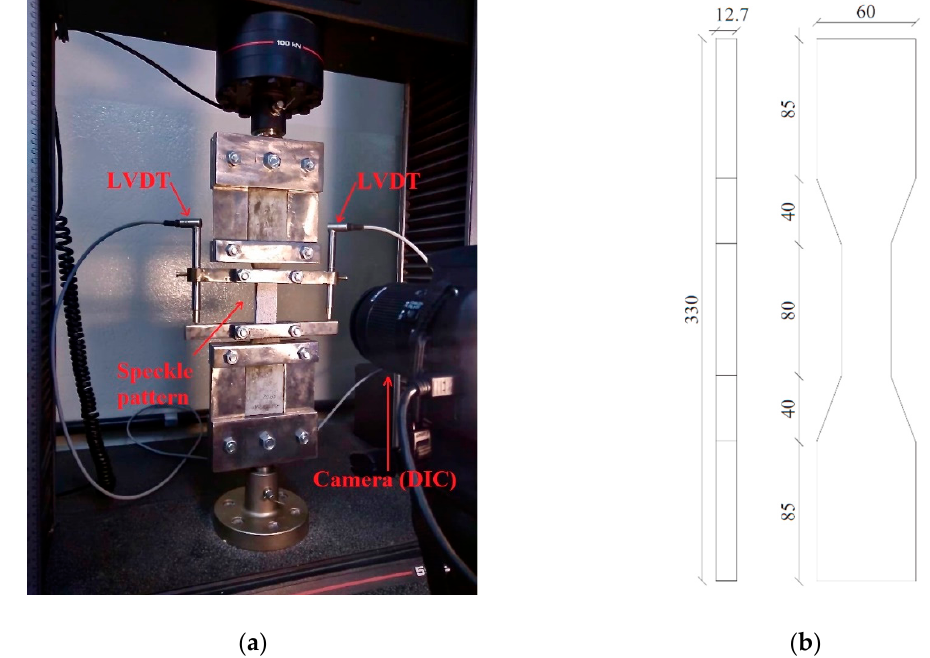
Figure 4. The direct uniaxial tensile test: ( a ) test setup with DIC and ( b ) specimen dimension